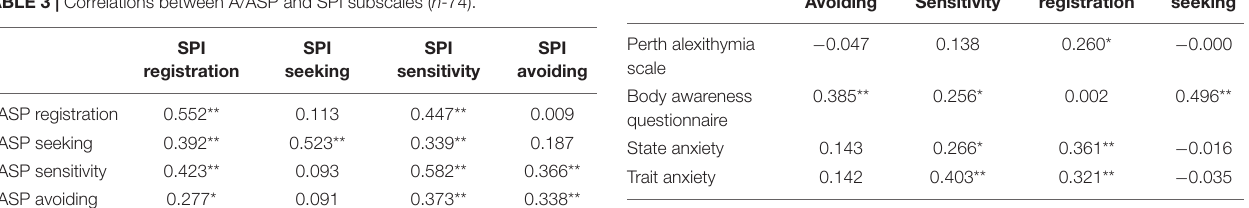
TABLE 3 | Correlations between A/ASP and SPI subscales ( n -74).